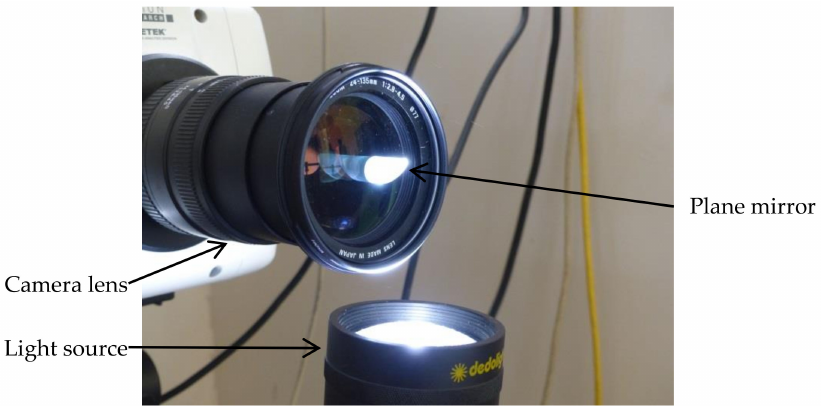
Figure 3. Detailed view of the lens of one of the cameras showing the small plane mirror used to direct the light on the same axis as the camera optical